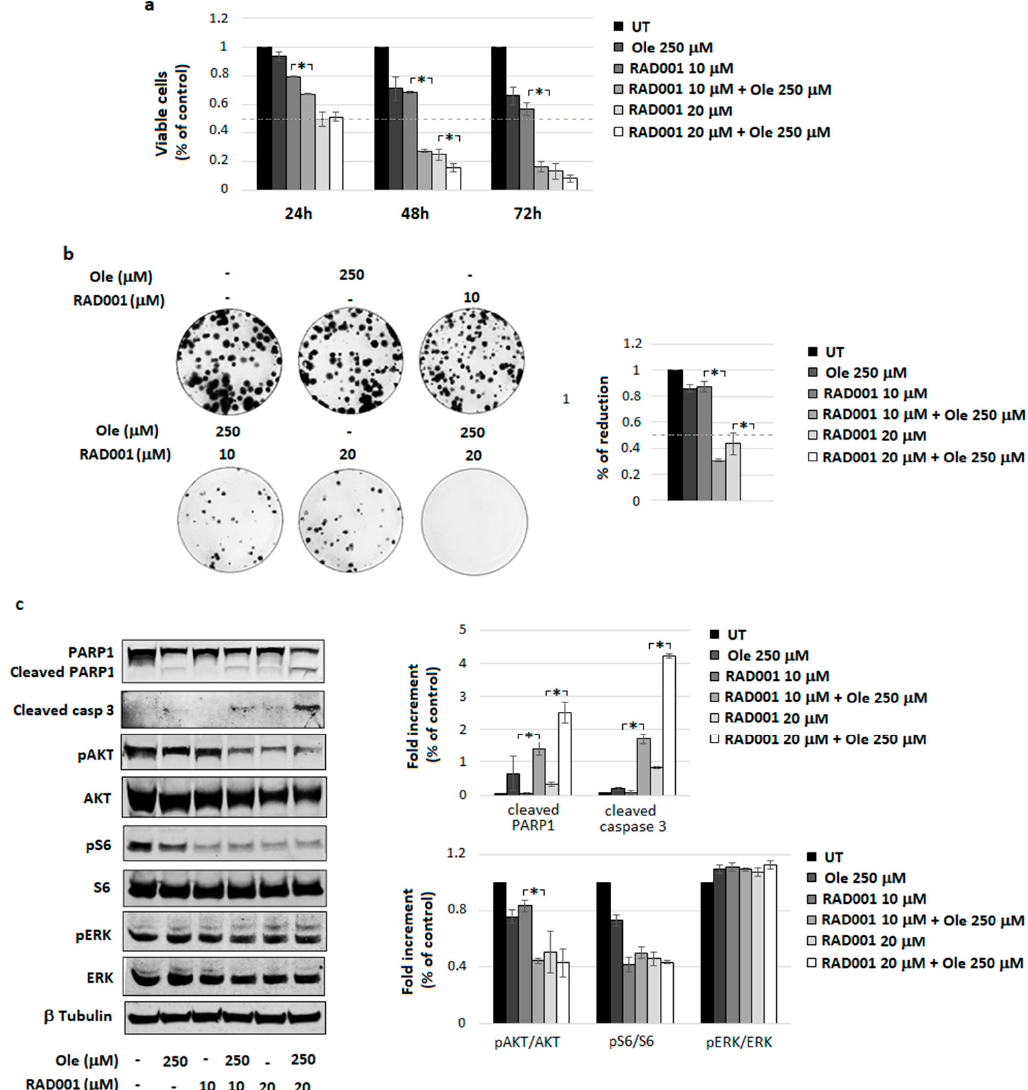
Figure 3. Ole-Everolimus (RAD001) efficacy on A375 melanoma cells. ( a ) Dose–time response evaluated via MTT assay. ( b ) ( Left ) Colonies forming units (CFU) assay of alive cells selected using a trypan blue exclusion test after a 250 µ M ( ≈ 125 µ g/mL) Ole treatment with and/or 10 and 20 µ M RAD001 ( ≈ 9.5 and 19 µ g/mL) for 48 h. ( Right ) Quantification data of the colony numbers compared to UT. ( c ) ( Left ) Representative Western blot of PARP1, cleaved PARP1, cleaved caspase 3, pAKT, AKT, pS6, S6, pERK, and ERK after 250 µ M Ole treatment with and/or 10 and 20 µ M RAD001 for 24 h. ( Right ) Densitometric quantification of the cleaved PARP1, cleaved caspase 3, and of the ratio of pERK/ERK, pAKT/AKT, and pS6/S6 relative to β -tubulin expression, expressed as a fold increment (%) compared to UT. * p ≤ 0.05 refers to Ole-RAD001 treatment vs. RAD001 alone. UT = untreated.